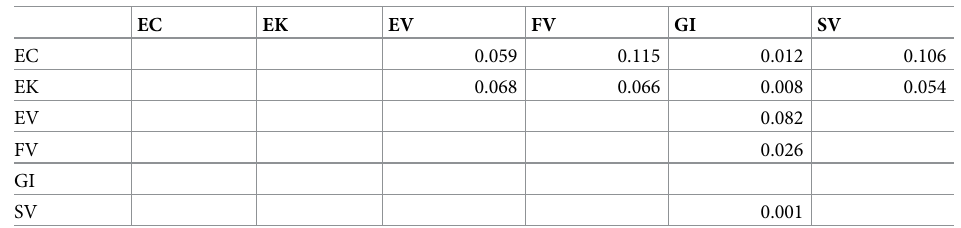
Table 6. Effect size ( F